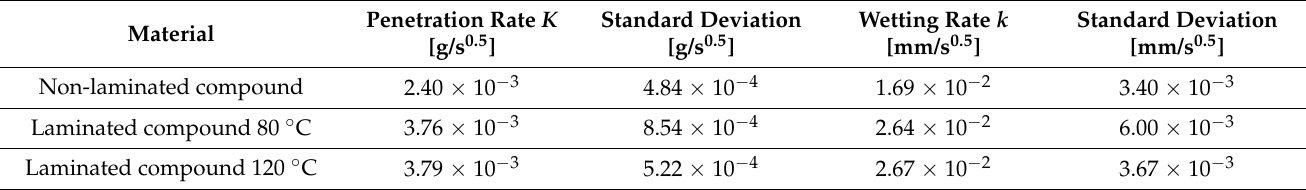
Table 1. Evaluated parameters penetration rate K and wetting rate k for the cathode separator measurement series (i) to (iii).